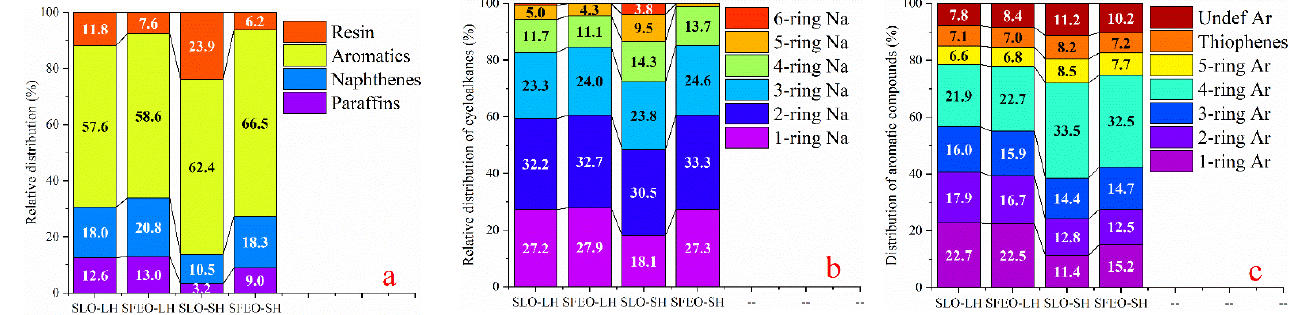
Figure 3. Hydrocarbon composition of SLO and SFEO by GC–MS. ( a ) Hydrocarbon composition ( b ) naphthenic hydrocarbon and ( c ) aromatic